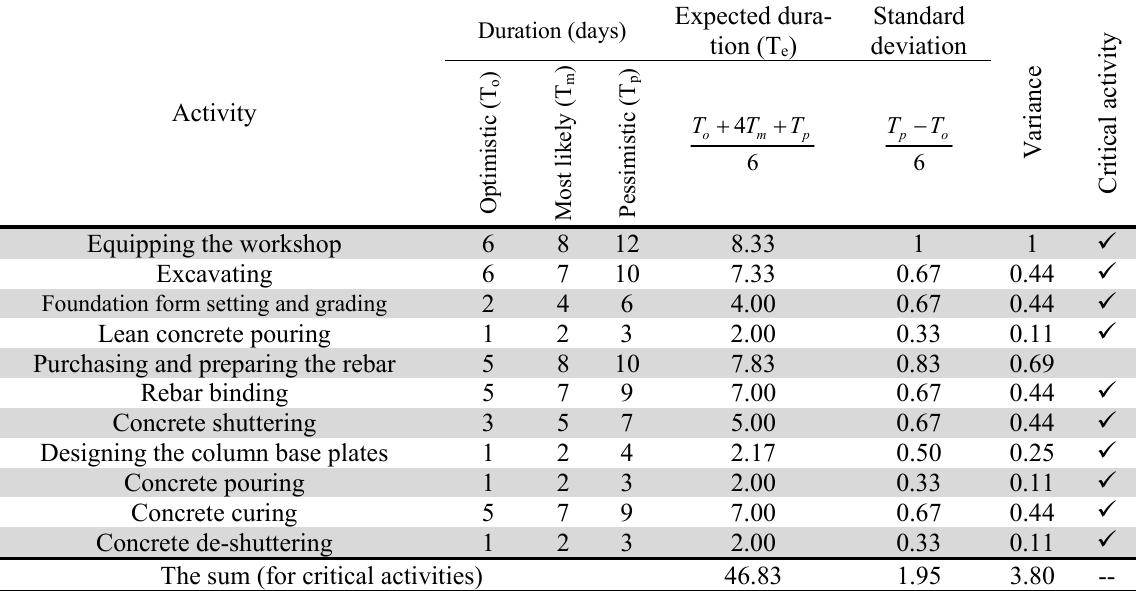
Calculation of expected duration, standard deviation and variance using